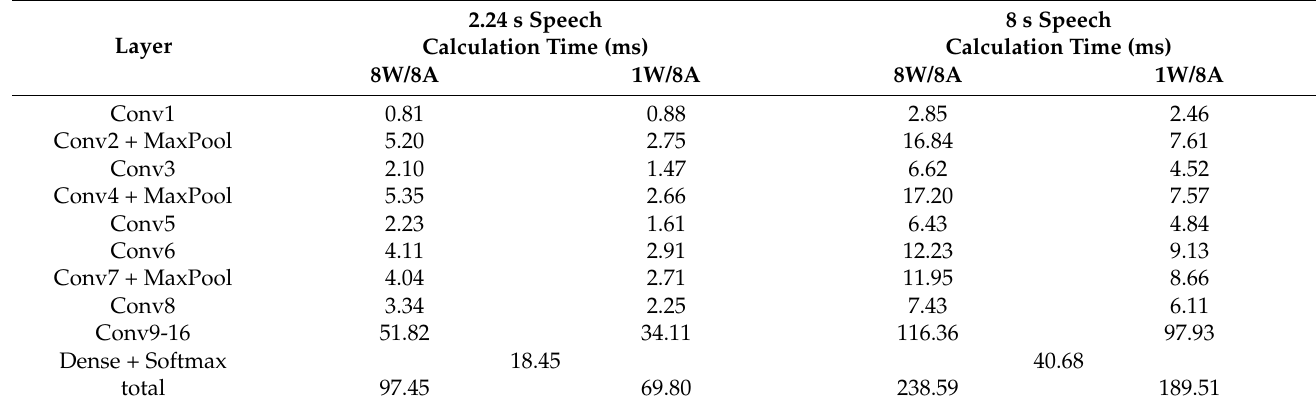
Table 5. The computational time of each layer for different speech.